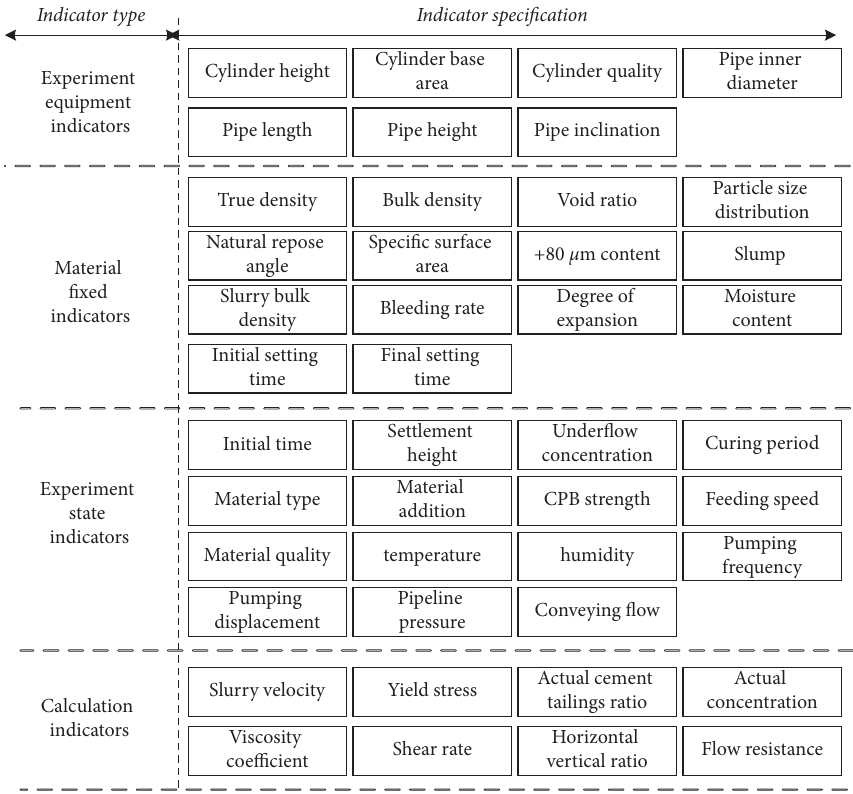
Figure 3: Backfill experiment indicator